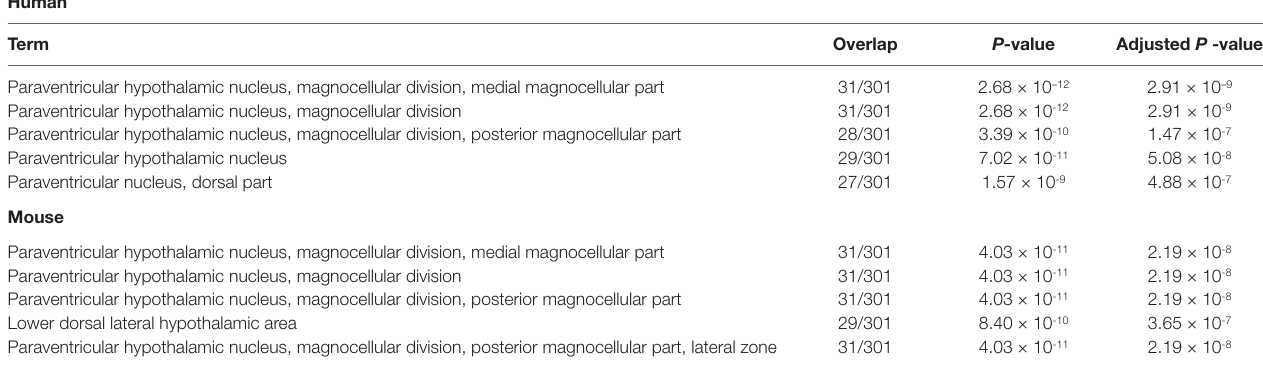
TABLE 4 | Five top-ranked terms from “Allen Brain Atlas up” by Enrichr for selected 456 human genes and 505 mouse genes. Human Term